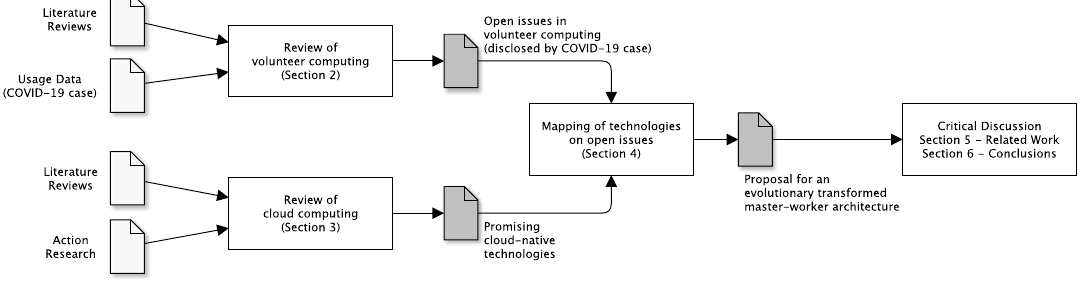
Figure 3. Research